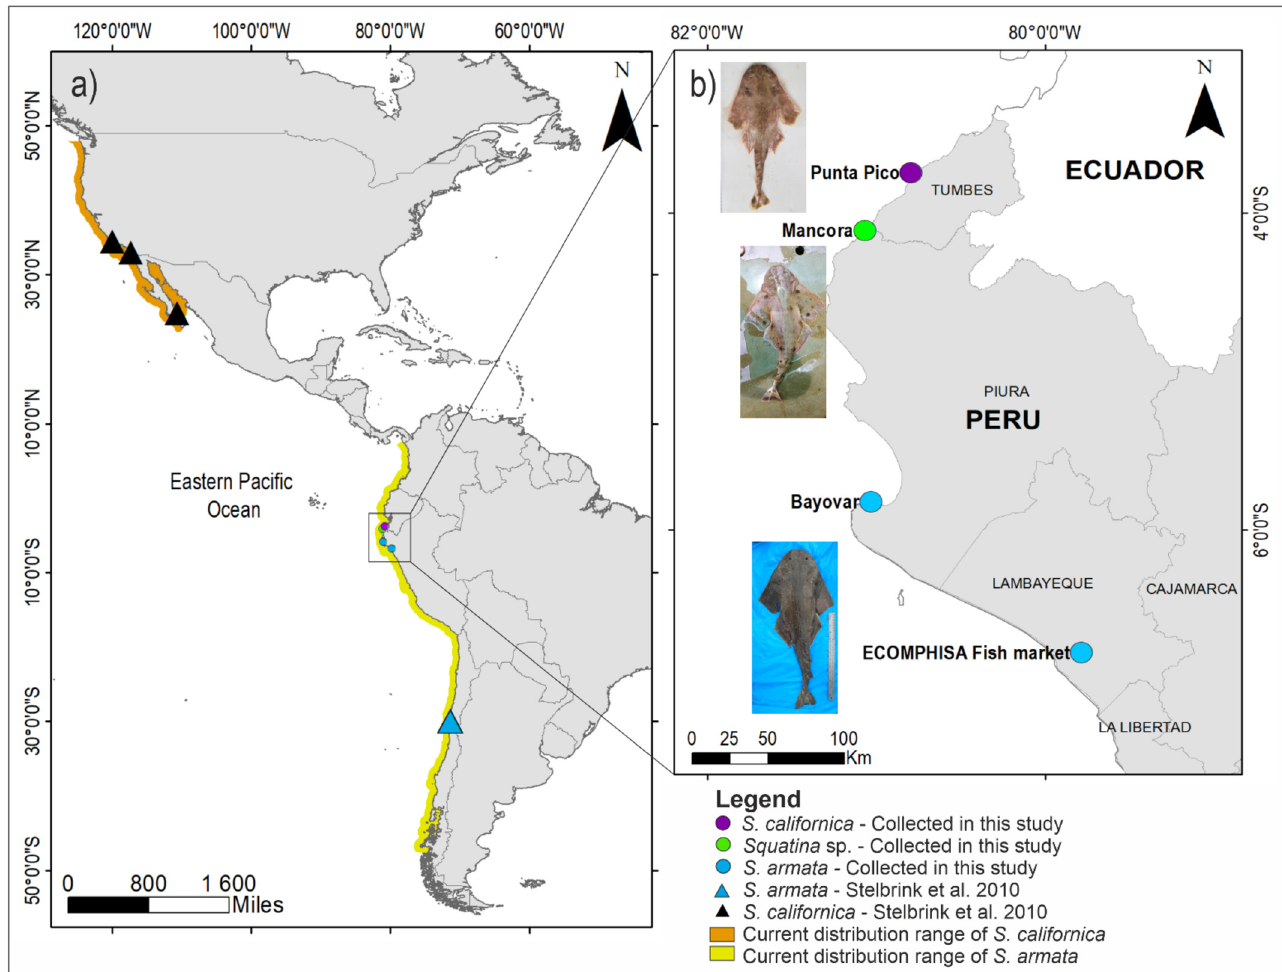
Figure 1. Geographic distribution map and sampling sites of DNA sequences of Squatina species along Eastern Pacific Ocean. ( a ) Current known distribution range adapted from Fricke et al., (2020) and sampling sites of Squatina californica (black triangle) and Squatina armata (light blue triangle) reported by Stelbrik et al., 2010. ( b ) Sampling sites of Squatina californica (purple circle), Squatina sp. (green circle), and Squatina armata (light blue circle) selected by PeMar Project in northern Peru.